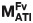
Histogram of half-sarcomere lengths in model MATIFv with distributed material properties after an active stretch from L/L0 = 1.05 to 1.25 (red) and after a fixed-length contraction at the same final length L/L0 = 1.25 (blue).This figure compares steady-state results, i. e. transient effects of the force-velocity relation have disappeared. Left: Variable passive properties, right: Variable active properties.